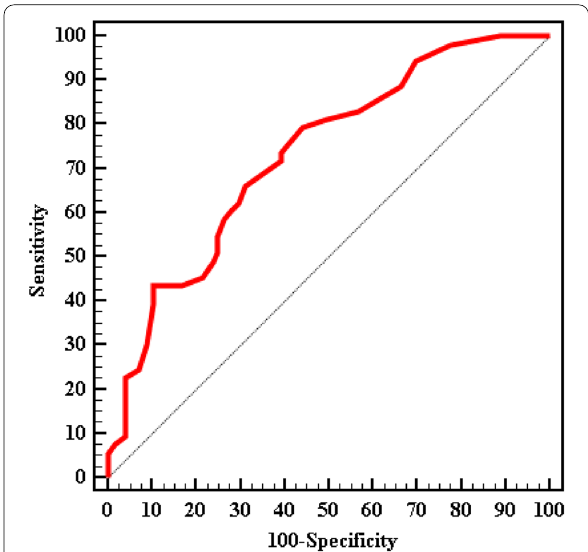
53 vs. 125). Fig. 2 ROC curve for HbA1c to diagnose NAFLD patients ( n = 125). Cutoff point > 5.1%, sensitivity 79.25%, specificity 41.60%, and area under the curve 0.665 (95% CI